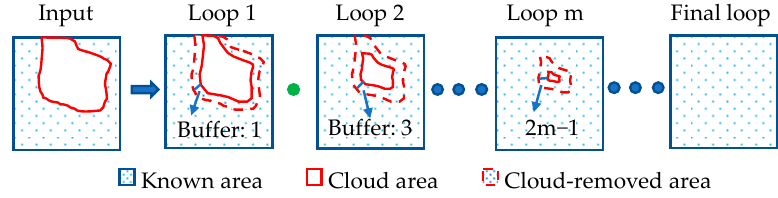
Figure 3. Neighborhood interpolation. Note: the green circle indicates omitting the GKF-based weighting integration and error correction of STF-GKF-EC. The blue circle indicates omitting similar recursive processing of STF-GKF-EC.